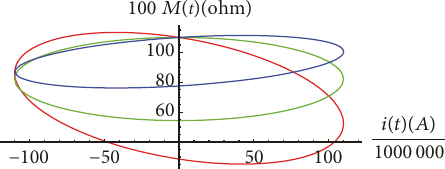
Figure 20: 𝑀(𝑡) - 𝑖(𝑡) of the fractional order memristor ( 𝐼 𝑚 > 0 ): 𝛼 = 0.75 (red), 𝛼 = 1 (green), and 𝛼 = 1.25 (blue).